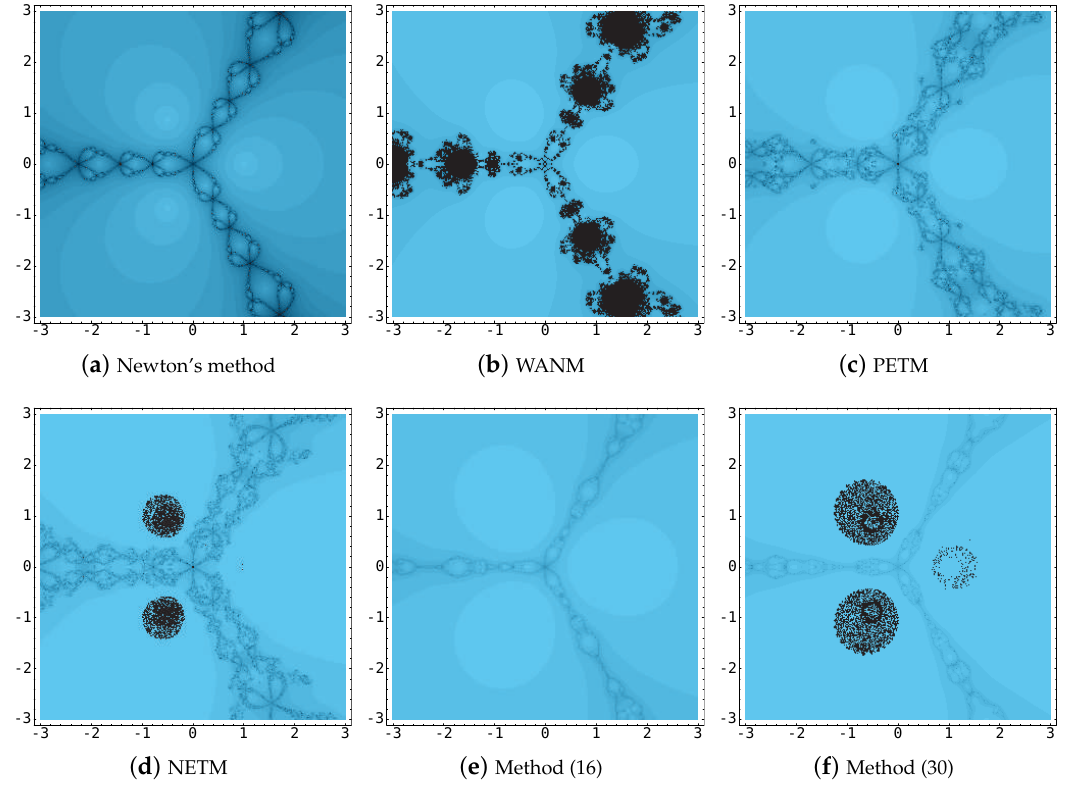
Figure 2. The results are for the polynomial z 3 − 1.